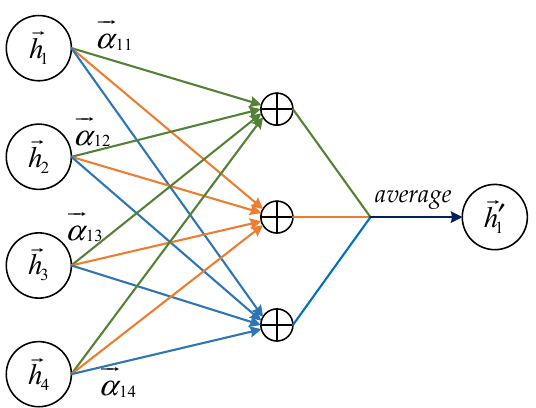
Figure 4. An illustration of multi-head attention (with K = 3 heads) by bus 1 on its adjacent bus.